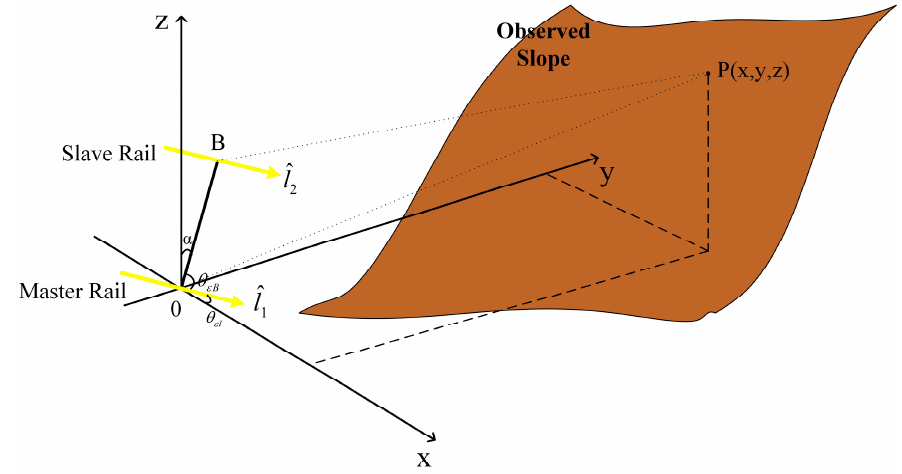
Figure 2. Ground-based interferometric synthetic aperture radar (GB-InSAR) system coordinates.